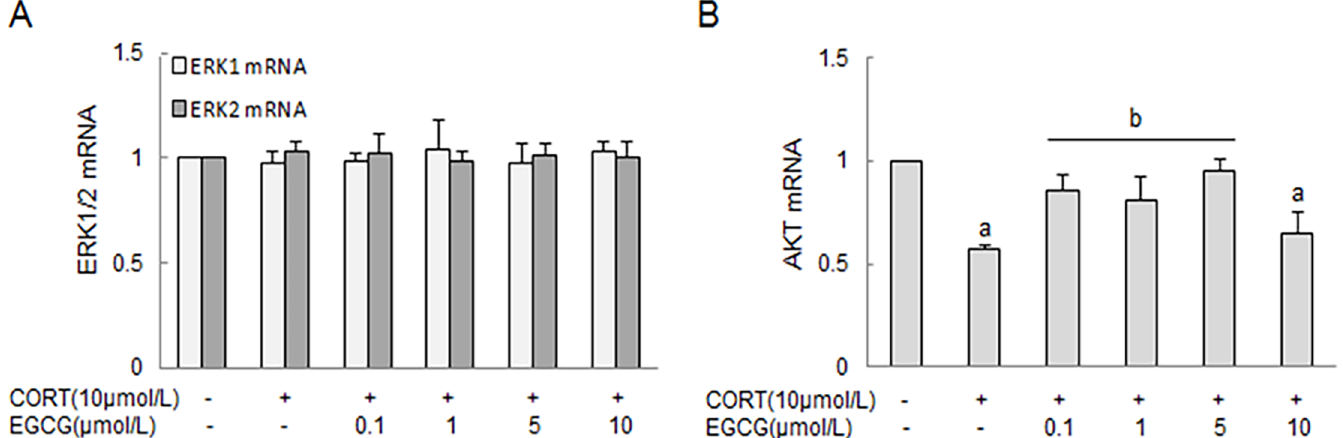
Fig 7. The effect of CORT and EGCG on ERK1/2 and AKT mRNA in primary hippocampal neurons. Primary hippocampal neuron cultures were pre-treated with EGCG for 2 h at indicated concentrations before stimulation with CORT for 24 h. The total RNA was isolated to measure the expression of ERK1/2 and AKT mRNA by RT-PCR, and expressed as mean ± SD of GAPDH mRNA levels. A) The expression of ERK1/2 mRNA; B) The expression of AKT mRNA. a P < 0.05 vs normal control group: b P < 0.05 vs CORT treatment group.